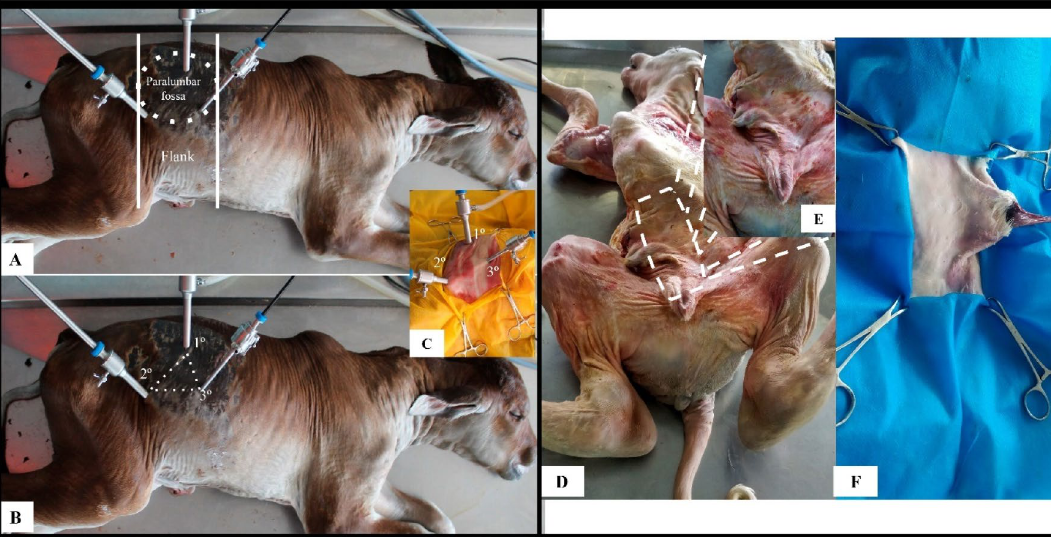
Figure 1. Positions of bovine fetuses that underwent laparoscopy and celiotomy for umbilical vein and urachal resection. ( A , B ) show the flank region and triangulation of laparoscopic ports. ( C ) shows the umbilical and preputial regions and surgical